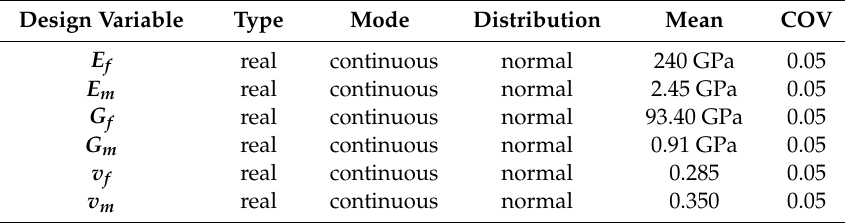
Table 5. Design variable of the micro-level.